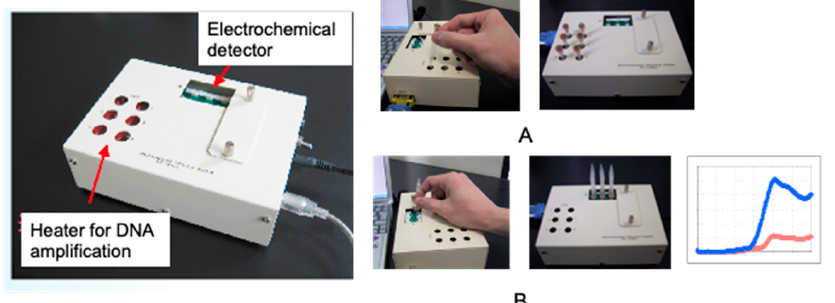
Figure 7. Electrochemical detector with heater for DNA amplification. ( A ): DNA stick set at heater for DNA amplification; ( B ): Electrochemical detection after operation of DNA stick shown in Figure 6.